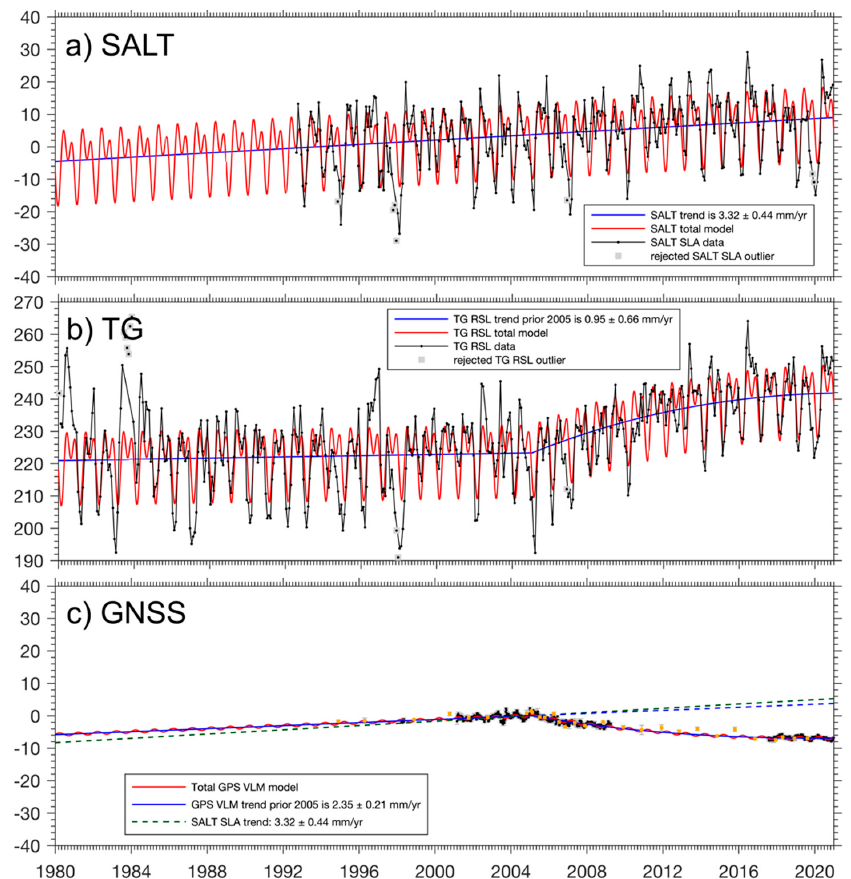
Figure 6. Top to bottom, at KTN tide-gauge station (Phuket) ( Y -axis in cm, X -axis in years), ( a ) the absolute sea-level (SLA) from altimetry (1992–2020), ( b ) the relative sea-level heights from the tide gauge (1980–2020), and ( c ) VLM as measured by GNSS (1994–2020) which is fitted with a seasonal cycle [20] . This seasonal cycle was estimated along with linear and non-linear functions . The green dotted line in the vertical position time series gives the sea-level change trend as estimated from satellite altimetry (SALT) . The vertical height reference point was set at the time of the Mw 9 . 2 earthquake (26/12/2004) as it initiated significant (post-seismic) changes in the vertical position. In all plots, the solid blue lines before 2005 indicate the linear part (trend), which was obtained by a robust fit of a parametric model consisting of bias, trend and annual and semi - annual periodic signals . Directly after the earthquake (after 2005), the trend is replaced with an exponential decay for TG RSL ( b ) and GNSS VLM ( c ). For the fit we applied a 3 σ outlier criterion to filter out extremes like in 1997 the low sea-level event in the Indian Ocean caused by the Indian Ocean Dipole ( IOD ). Results have not been corrected for GIA, since its effect is small anyways but also will cancel in all the mutual comparisons between GPS, TG, and SALT .